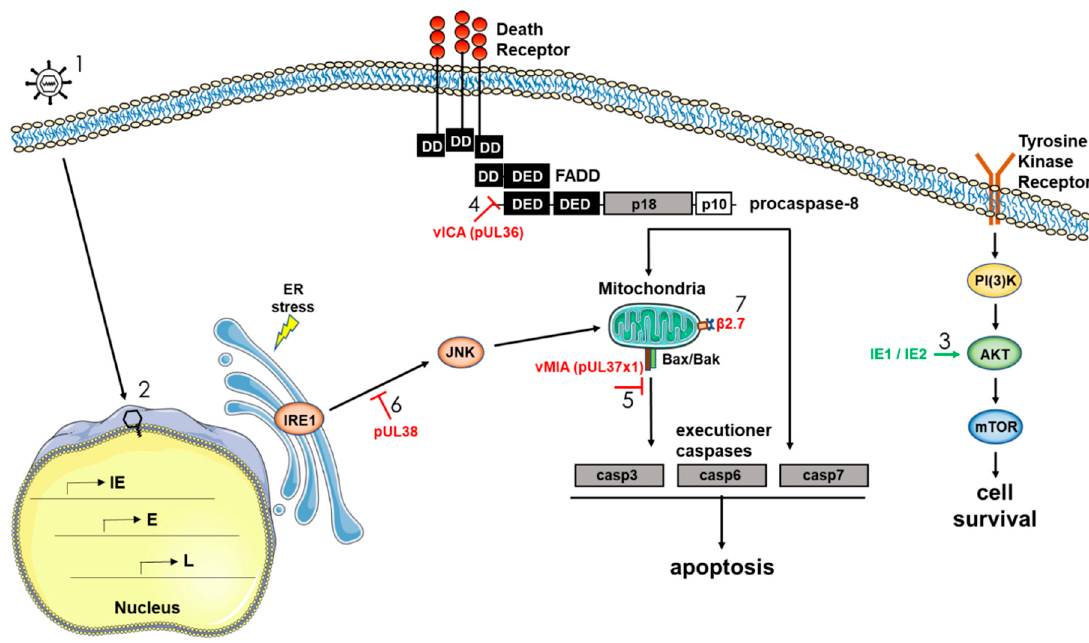
Figure 3. Select HCMV gene products that target apoptotic pathways during HCMV infection. (1) HCMV enters a target cell and (2) the viral capsid is trafficked to the nucleus. The viral genome is translocated into the nuclear space and initiation of viral gene expression occurs. A number of viral gene products have been shown to alter the cellular environment to promote a pro-survival state. (3)